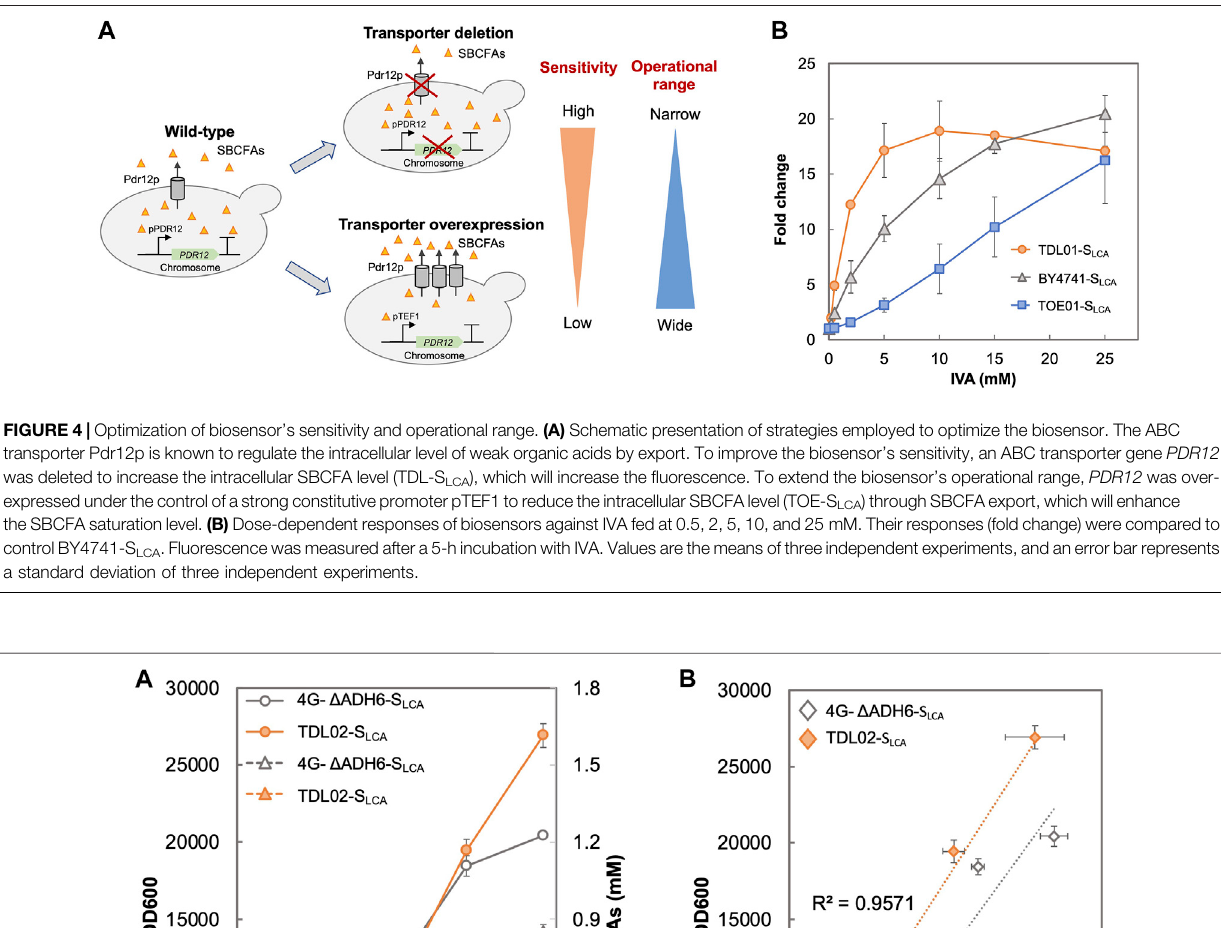
Frontiers in Bioengineering and Biotechnology |